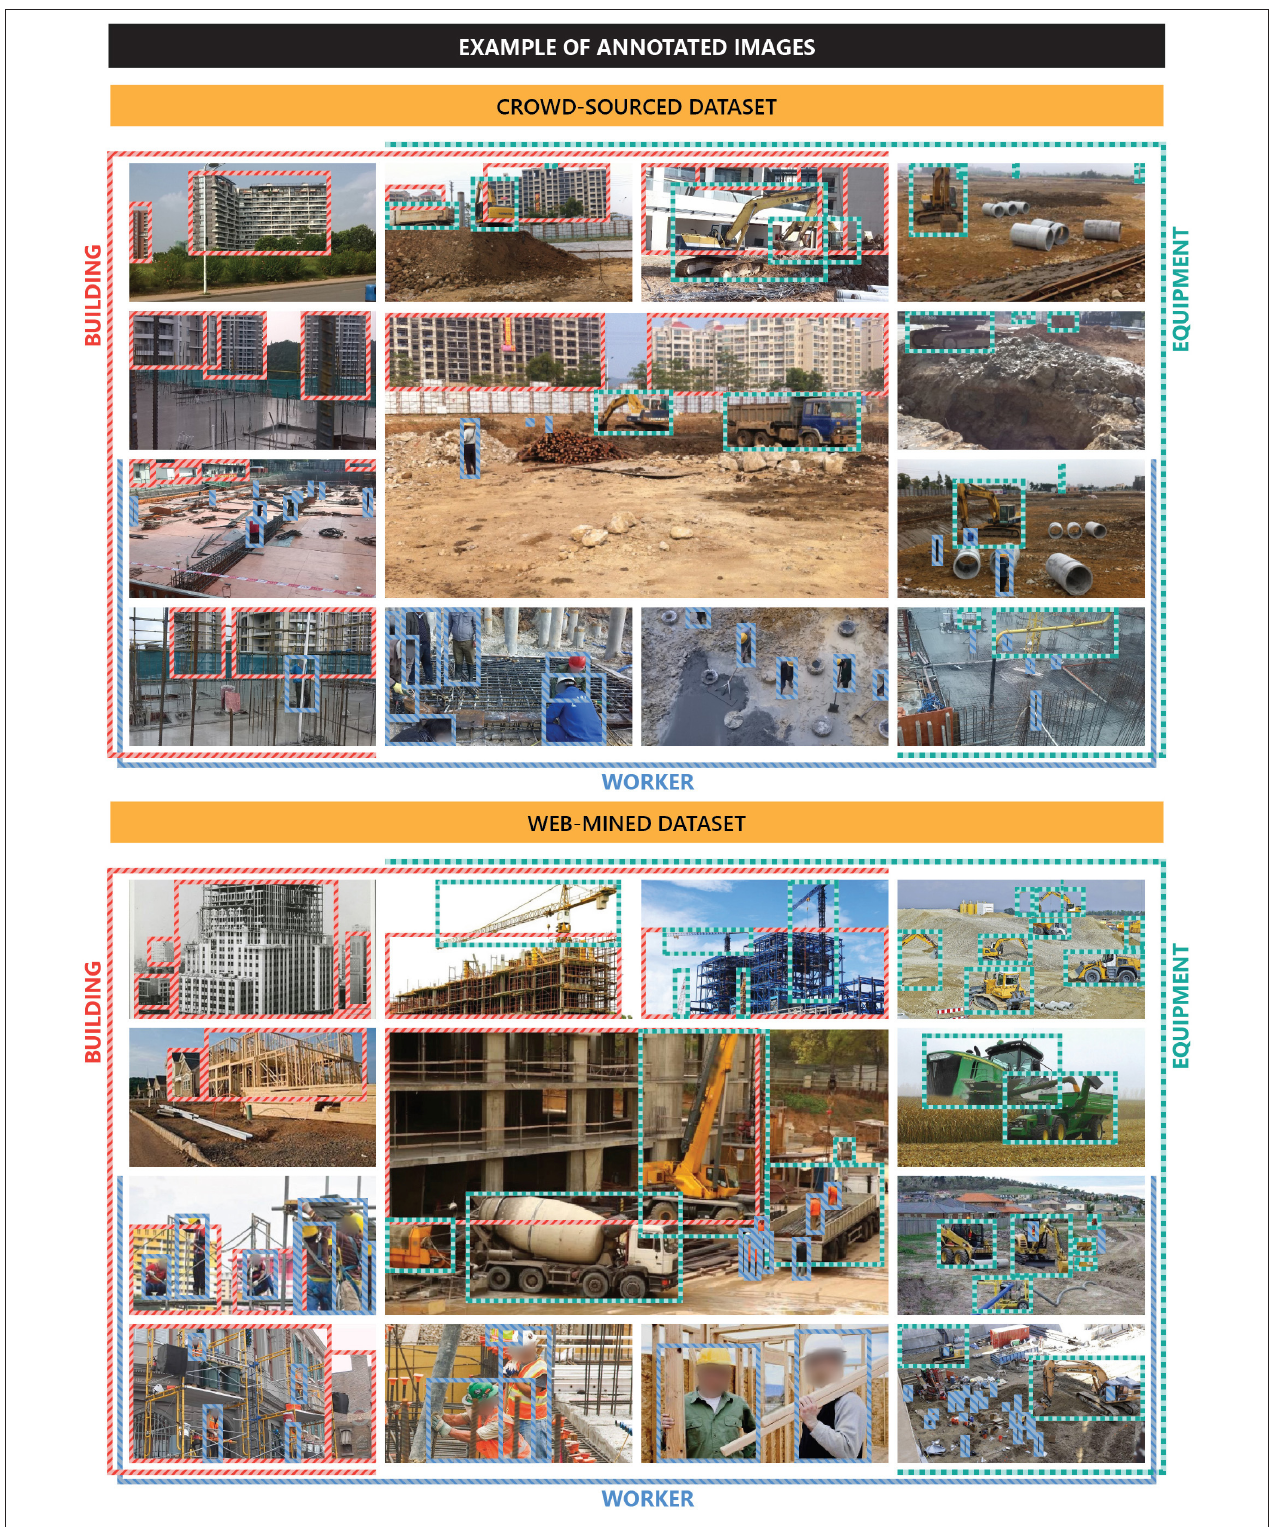
FIGURE 4 | Sample crowdsourced and web-mined images with ground-truth boxes in the Pictor-v2 dataset.